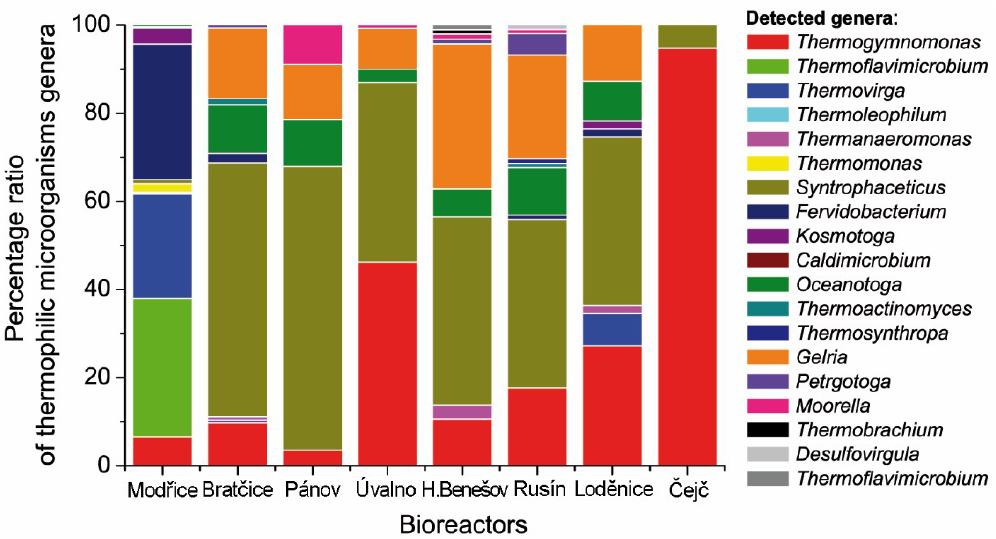
Figure 5. Percentage of each thermophilic genus in the overall population of thermophiles in each anaerobic fermenter.